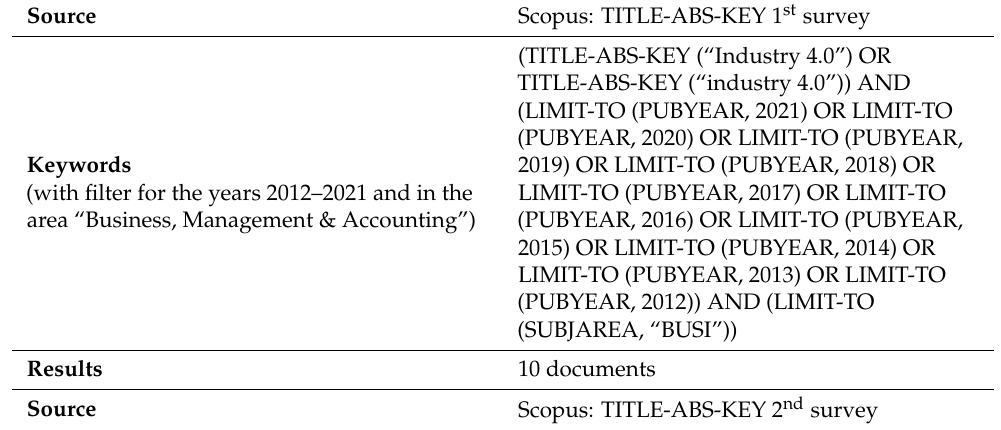
Table 1. Scopus search